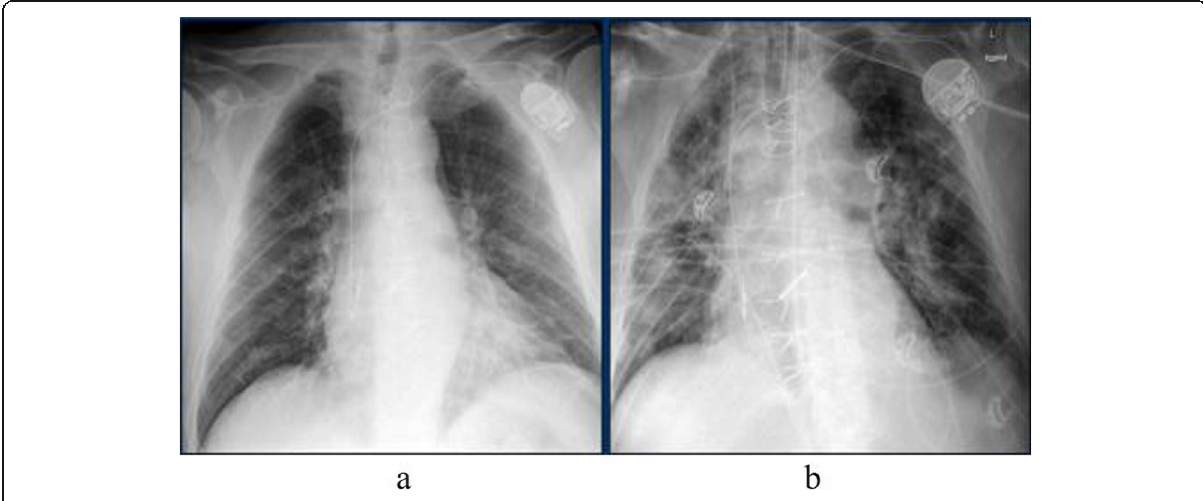
Fig. 4 X-rays of a patient with COVID-19. a Normal; b After 4 days with bilateral consolidations [26]